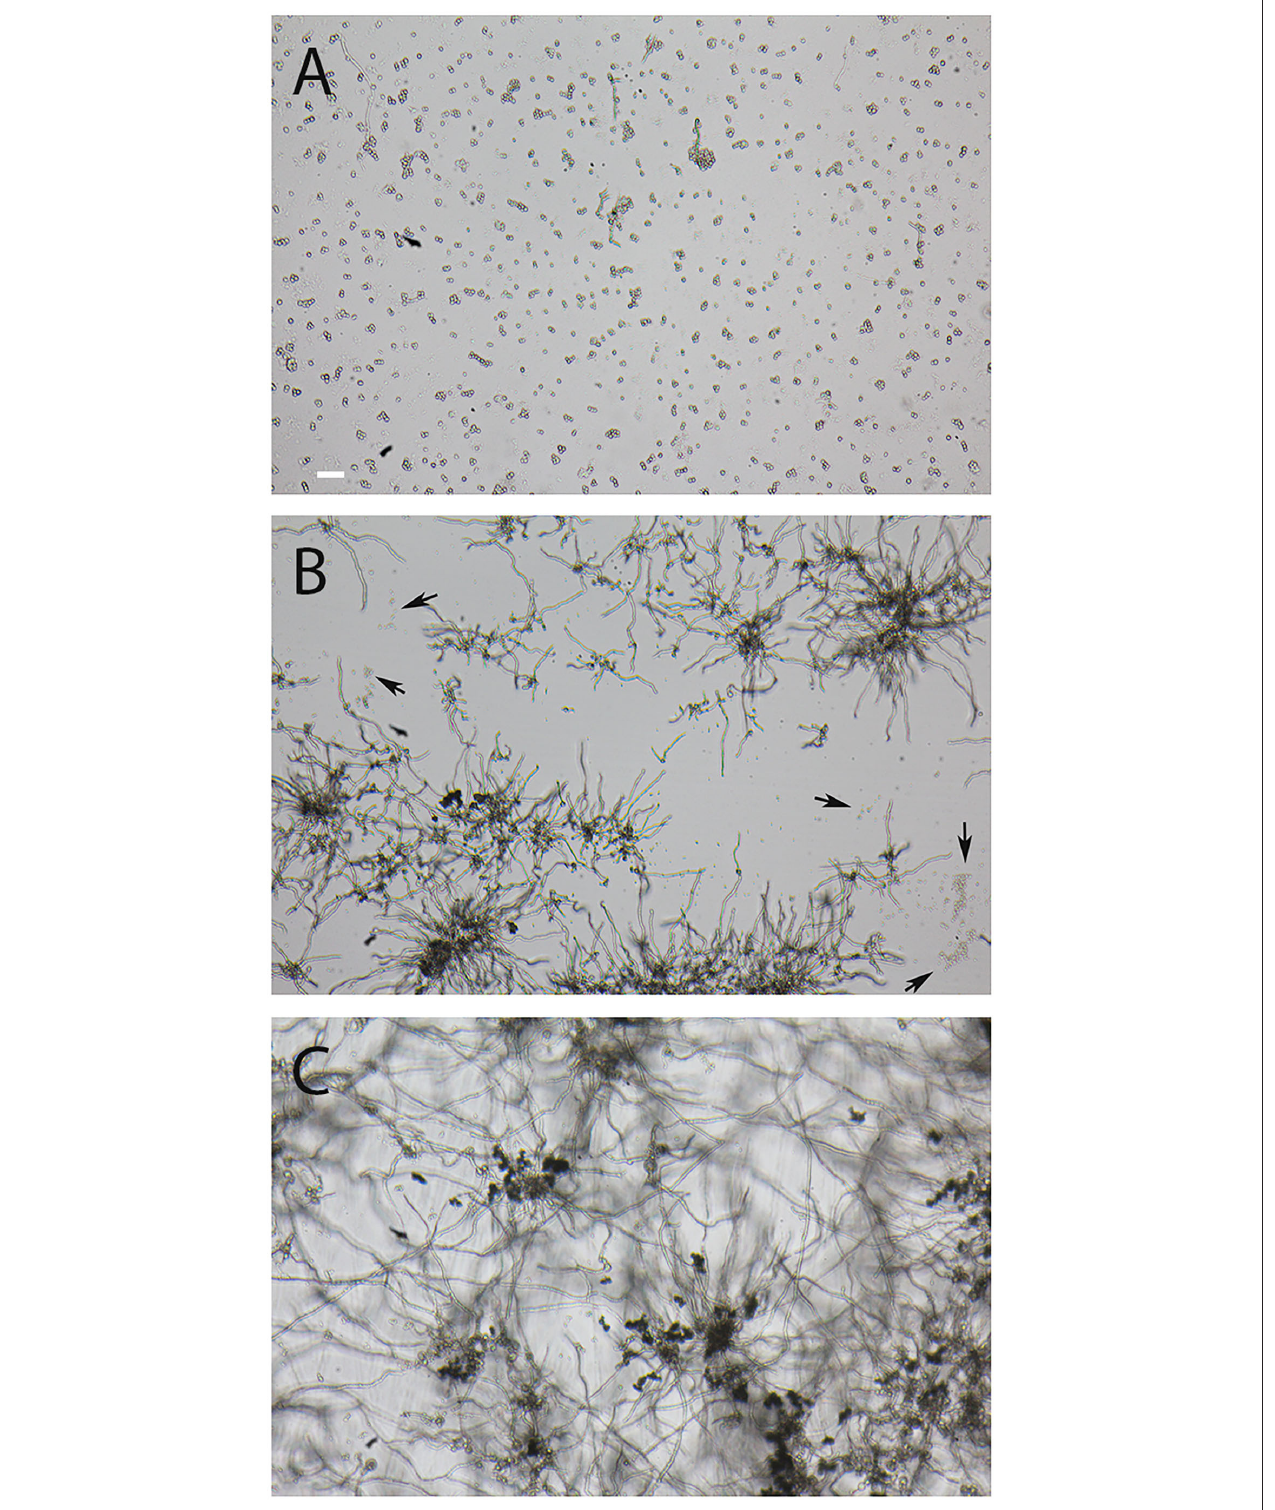
FIGURE 6 | Comparison of the resistance of AC and PC to desiccation. Small droplets of conidial suspension were placed on the surface of Petri dishes and desiccated for 16h at 37 ◦ C. The conidia were then covered with Sabouraud medium and further incubated for 14h at 37 ◦ C. (A) shows AC of strain At17-14, the corresponding PC are depicted in (B) . Arrows indicate clusters of At17-14PC showing no signs of activation. (C) shows PC of the A. fumigatus strain D141for comparison. The bar in (A) represents 50 µ m and is valid for all panels.